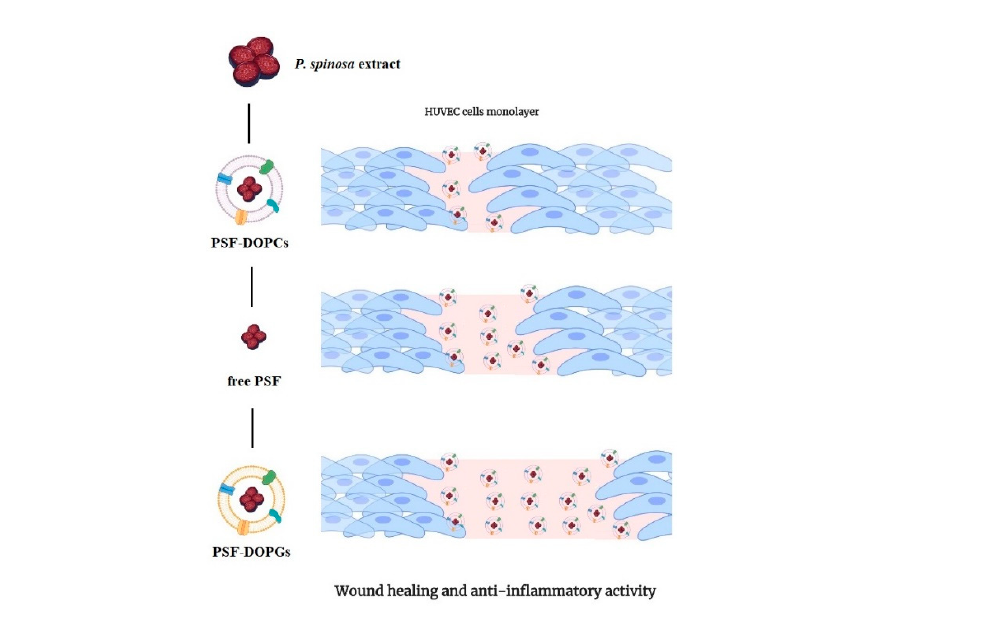
Figure 7. Free P. spinosa extract (free PSF) and loaded biomimetic formulations (PSF-DOPCs and PSF-DOPGs) acting on wound healing. As shown, PSF-DOPCs are the most efficient in wound closure, followed by free PSF and, finally, PSF-DOPGs, which are the least performing. On the other hand, PSF-DOPGs did not significantly modulate the molecules associ- ated with the TLR4 pathway, as for the empty DOPCs and DOPGs. However, the latter lowered the level of IL-6 associated with inflammation, probably due to the intrinsic anti- inflammatory capacity of the biomimetic nanovesicles [19]. The wound-healing effect of PSF-DOPGs was considerably lower compared to the free PSF extract and PSF-DOPCs probably due, as we report below, to (i) less efficient incorporation; and (ii) differences in active molecules incorporated (as shown by HPLC). In particular, PSF-DOPCs contained a higher amount of hydroxycinnamic acids (Table 1—Peaks no. 1–5, 7) and flavonoids including quercetin derivatives (Table 1—Peaks no. 6, 9, 17–24) that are known as wound- healing modulators [41]. Furthermore, molecules highly loaded into PSF-DOPCs such as caffeic acid and quercetin derivatives (quercetin xyloside) have already been explored in the literature showing an antioxidant [42] and anti-inflammatory effect through downreg- ulation of the TLR-4 signaling pathway [43,44]. On this basis, our findings seem to confirm that these are the components of the PSF extract most directly involved in determining the observed experimental results.